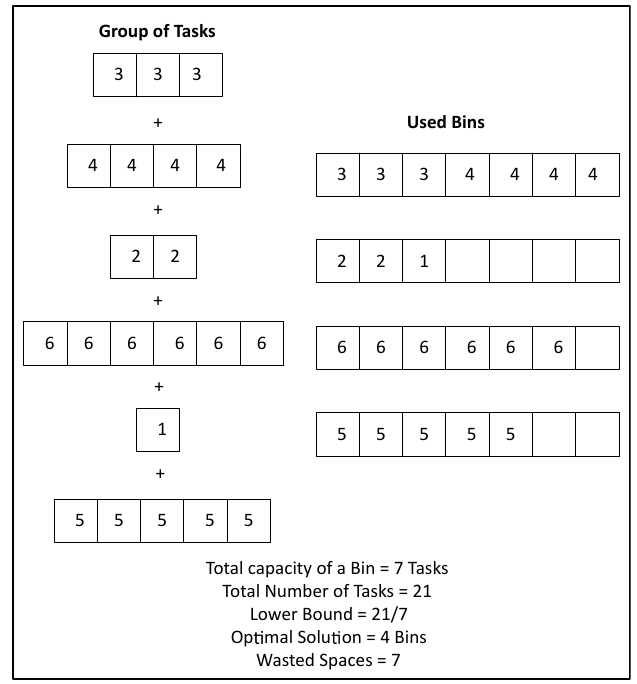
Figure 6. First Fit